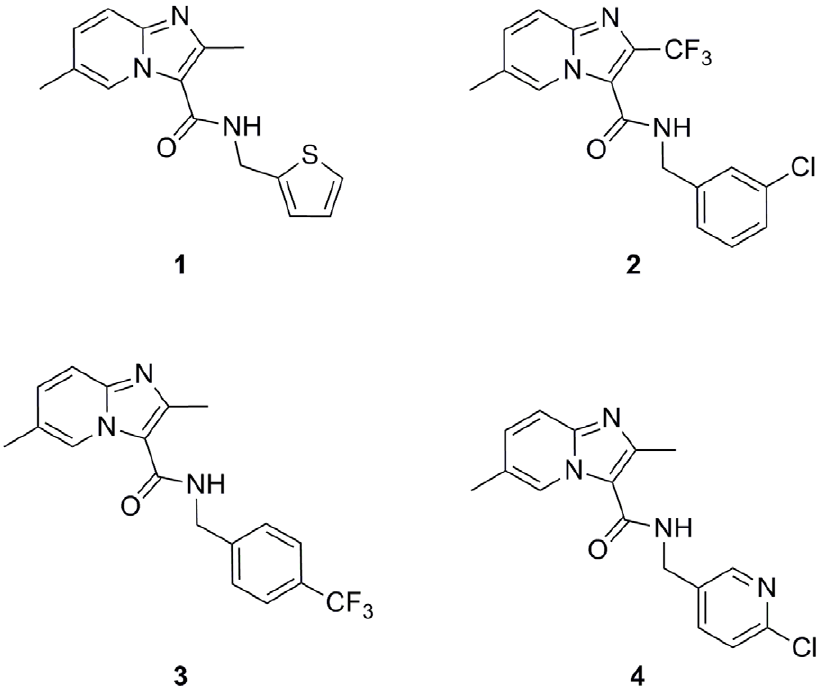
Figure 1. Compounds from the IP series active against M.tuberculosis . Structures of the initial IP hits ( 1 and 2 ) identified in the HTS campaign against M. bovis BCG (activity later confirmed in M. tuberculosis ) and of optimized compounds 3 and 4 .